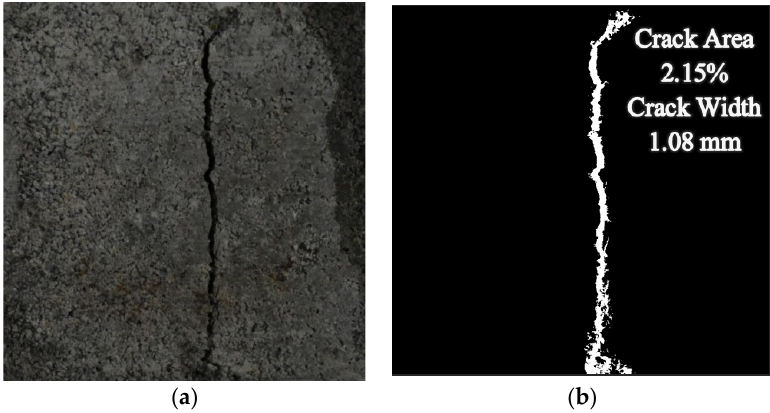
Figure 6. Cracked mortar sample . ( a ) RGB Picture, ( b ) binary Image.